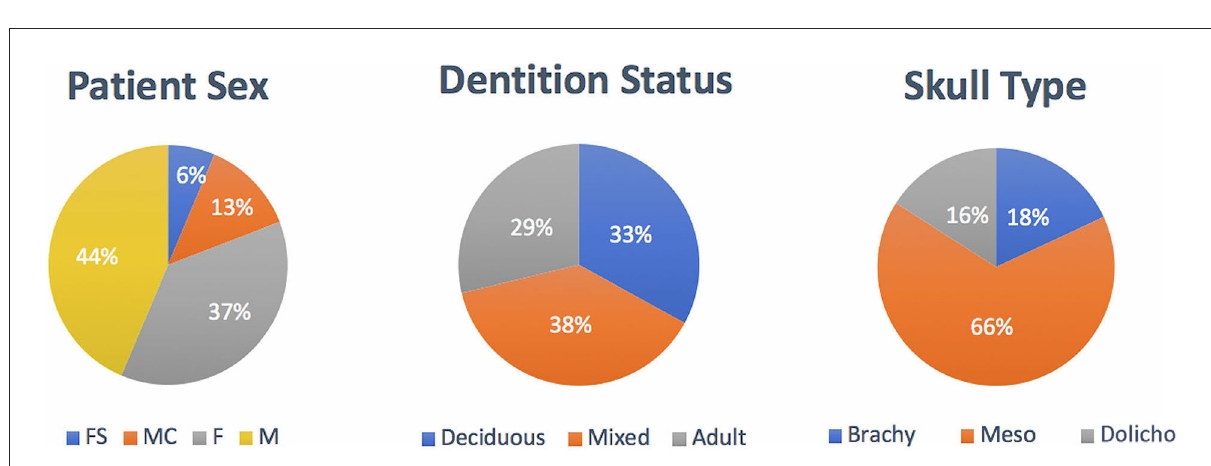
FIGURE7 Population distribution by patient sex, patient dentition status, and skull